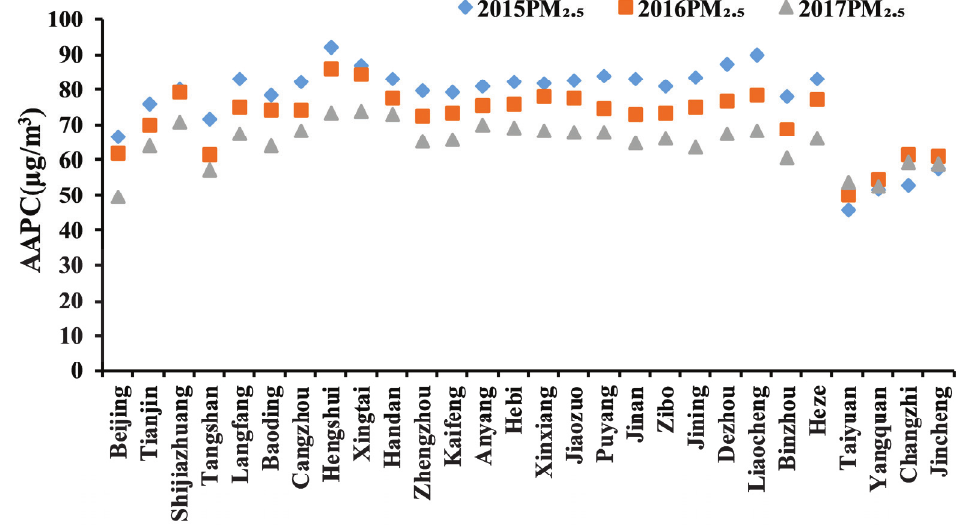
Figure 7. AAPC of 28 cities during 2015–2017.